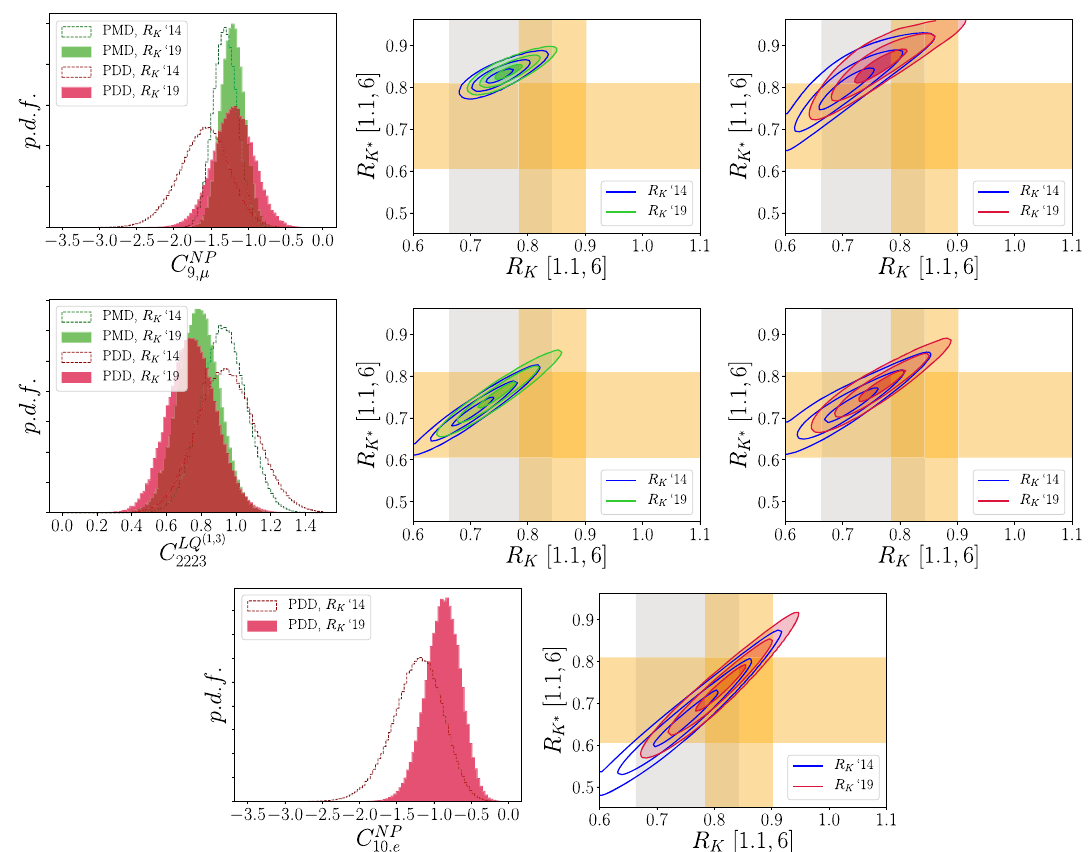
Fig. 3 First row: probability density function (p.d.f.) for the NP con- the colour scheme follows the one employed in the first panel. The hor- tribution to the Wilson coefficient C NP . The green-filled p.d.f. shows izontal band corresponds to the 1 σ experimental region for R K ∗ from 9 ,μ the posterior obtained in the optimistic approach to hadronic contri- [134], while the two vertical bands corresponds to the previous and the butions after the inclusion of the updated measurement for R K , while current 1 σ experimental regions for R K . Second row: analogous to the the red-filled p.d.f. is the analogous posterior obtained allowing for siz- first row, but relative to the SMEFT Wilson coefficient C LQ able hadronic contributions (the dashed posteriors are the ones obtained employing the 2014 R K measurement); the following panels report the combined 2D p.d.f. of the corresponding results for R K and R K ∗ , where